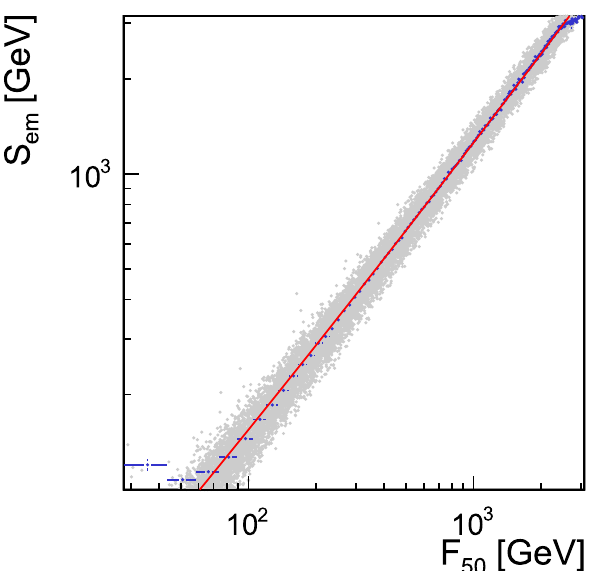
Fig. 3 Biasandtherelativeresolutionoftheestimator A 0 oftheenergy deposited at the ground, defined in Eq. 1, as a function of the energy deposited at the ground, S em (see text for the simulation